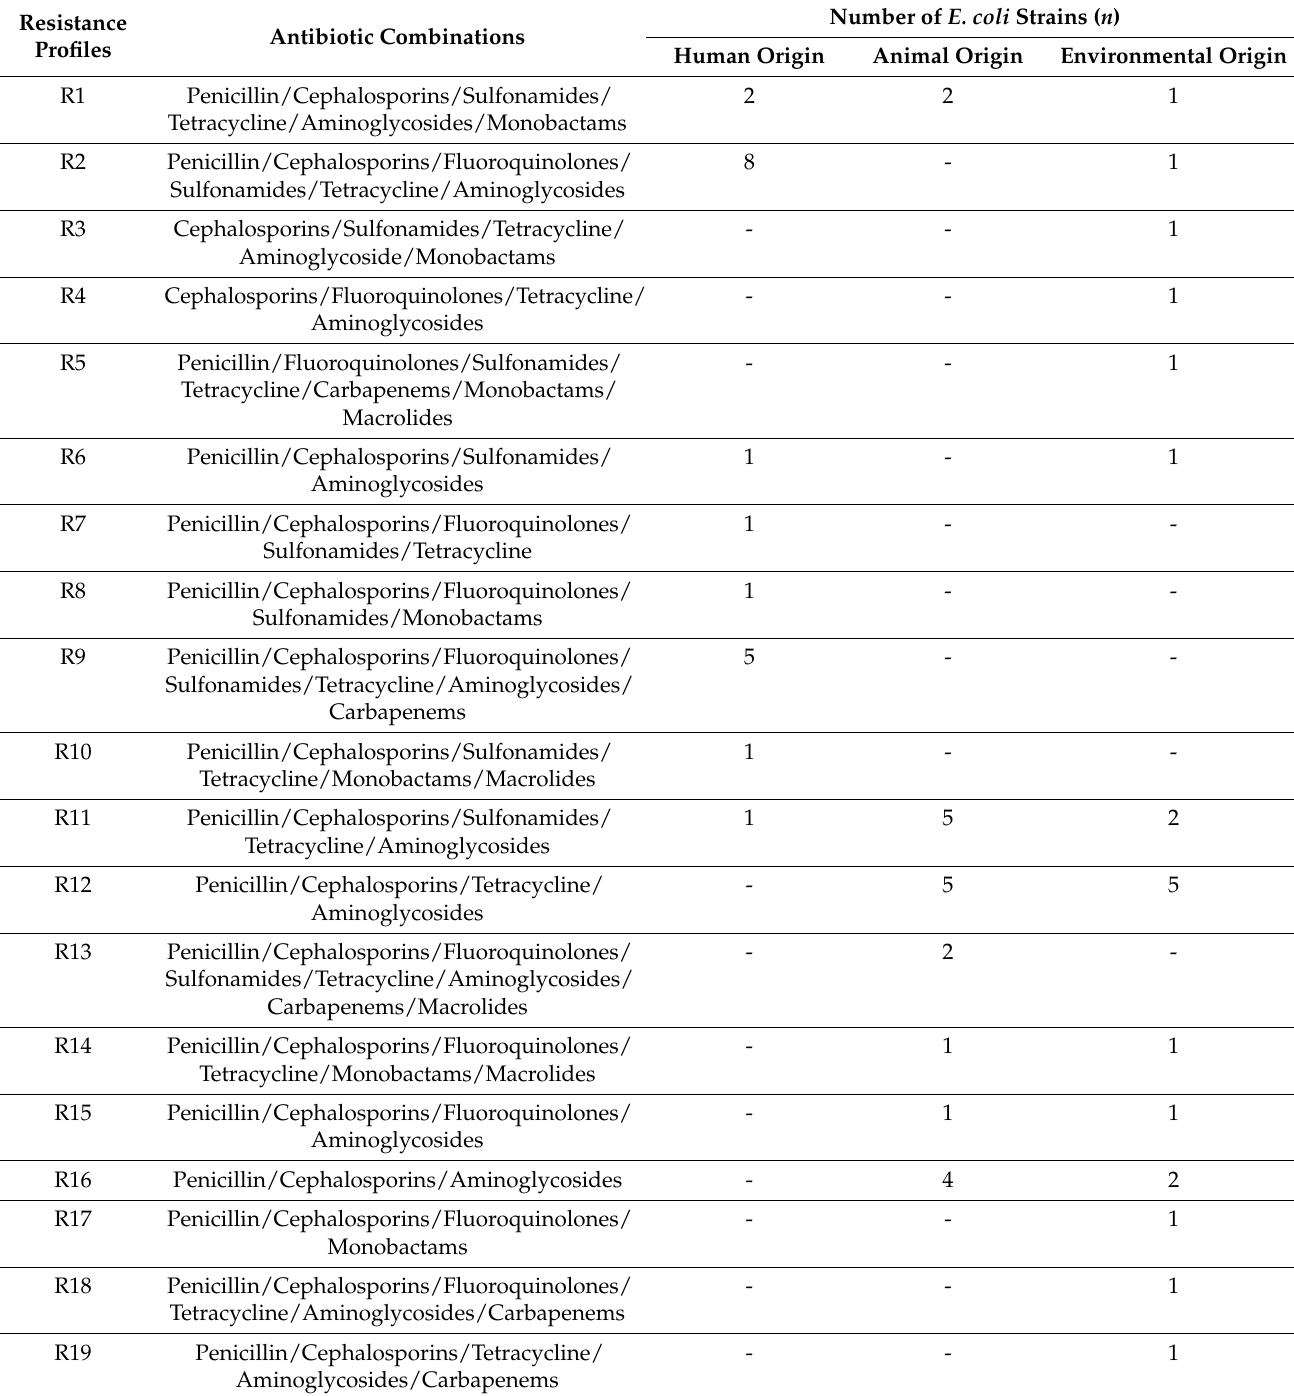
Table 1. Profiling of E. coli strains based on multiple antibiotic resistance